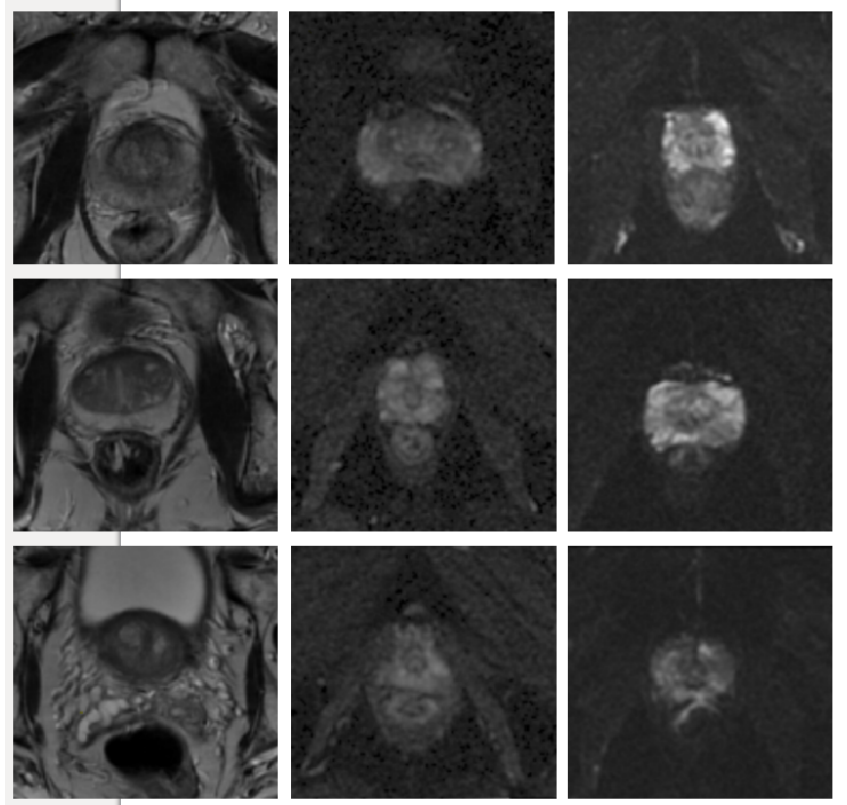
Figure A2. Some examples of T2W, ADC and DWI MR images from our dataset, which demonstrates that DWI and ADC modalities have lower signal around the prostate compared to the T2W